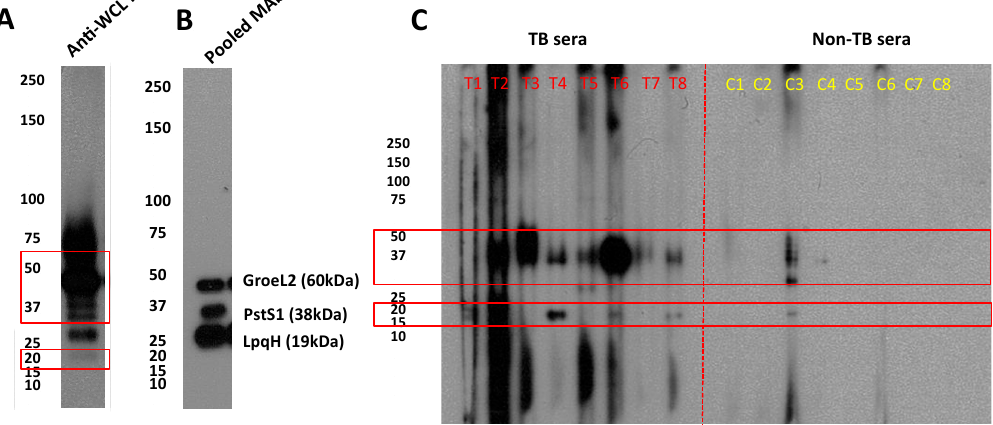
Figure 3. Proteins probed with ( A ) rabbit polyclonal anti-WCL antibodies, ( B ) pooled mouse Figure3. Proteinsprobedwith( A )rabbit polyclonalanti-WCLantibodies, ( B )pooled mousemonoclonal monoclonal anti-GroEL2 (HSP 65), anti-PstS1 (38 kDa antigen), anti-LpqH (19 kDa antigen) anti-GroEL2 (HSP 65), anti-PstS1 (38 kDa antigen), anti-LpqH (19 kDa antigen) antibodies, and ( C ) antibodies, and ( C ) individual TB patient (T, n = 8) and non-TB control (C, n = 8) serum IgG. individual TB patient (T, n = 8) and non-TB control (C, n = 8) serum